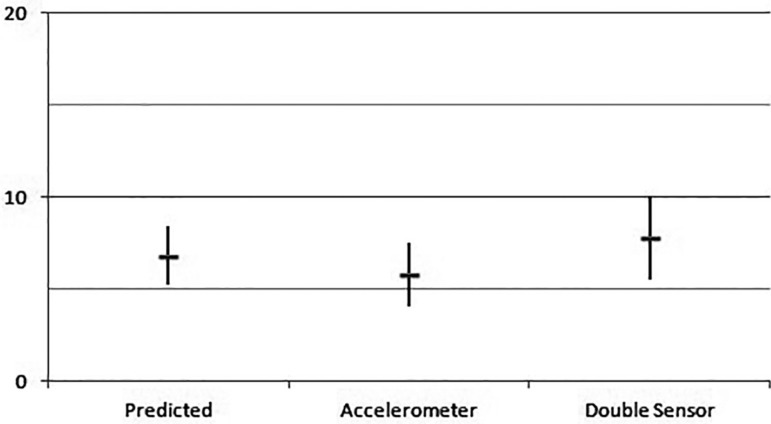
Average and standard deviation of metabolic equivalent in the different
groups.